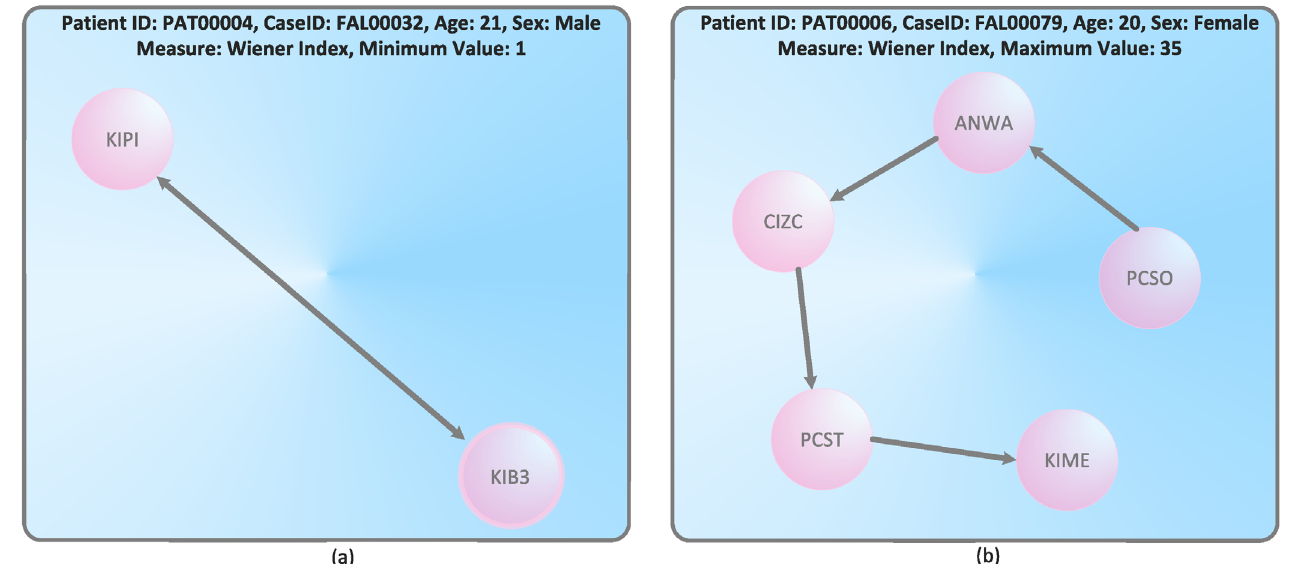
Fig 6. Treatment cycles with the minimal and maximal Wiener index.